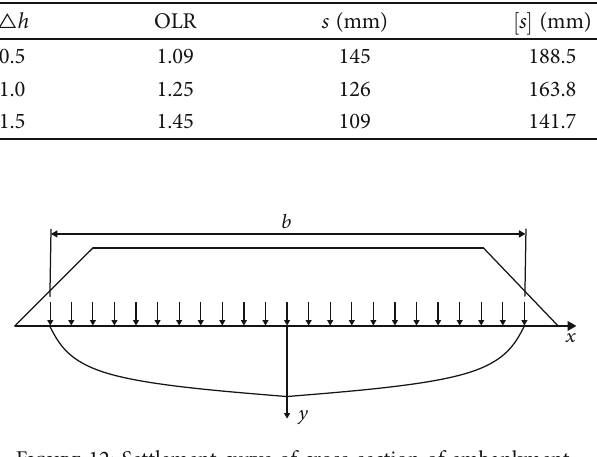
Table 5: Postconstruction settlement under di ff erent